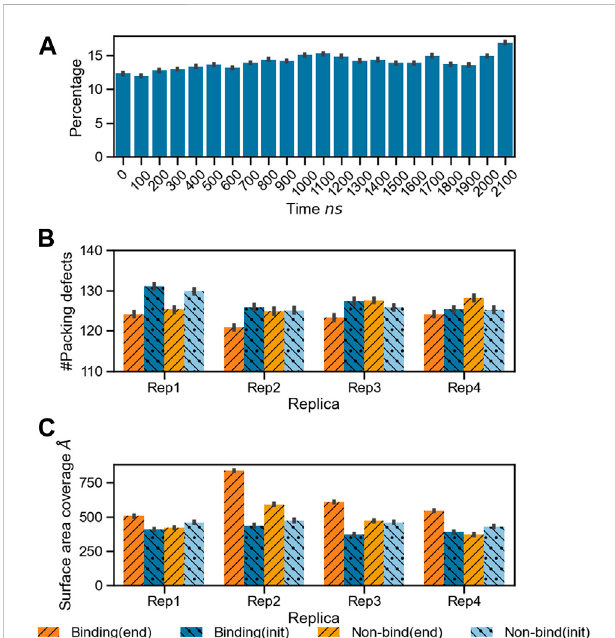
FIGURE 4 Changesinlipidpackingdefectsintheimmediateenvironmentdue to MLKL binding. (A) Bar plots for the percentage area of lipid packing defect at the protein binding site with respect to the projected protein surface area % (cid:1) 100 · ( local . defects / protein . area ) . Bars are plotted in time windows of 100 ns for the full trajectory of Rep3, and show a net increase in packing defects. (error bars indicate standard error). (B) Number of lipid packing defects per lea fl et at the beginning (blue tones withleftstripesanddots),andend(orangetoneswithrightstripes)ofthe simulation. (C) Total surface area of packing defects per lea fl et at the beginning (blue tones with left stripes and dots) and end (orange tones with right stripes and dots) of the simulation. Darker blue and orange represent the binding lea fl et, and lighter hues show data for the non- binding lea fl